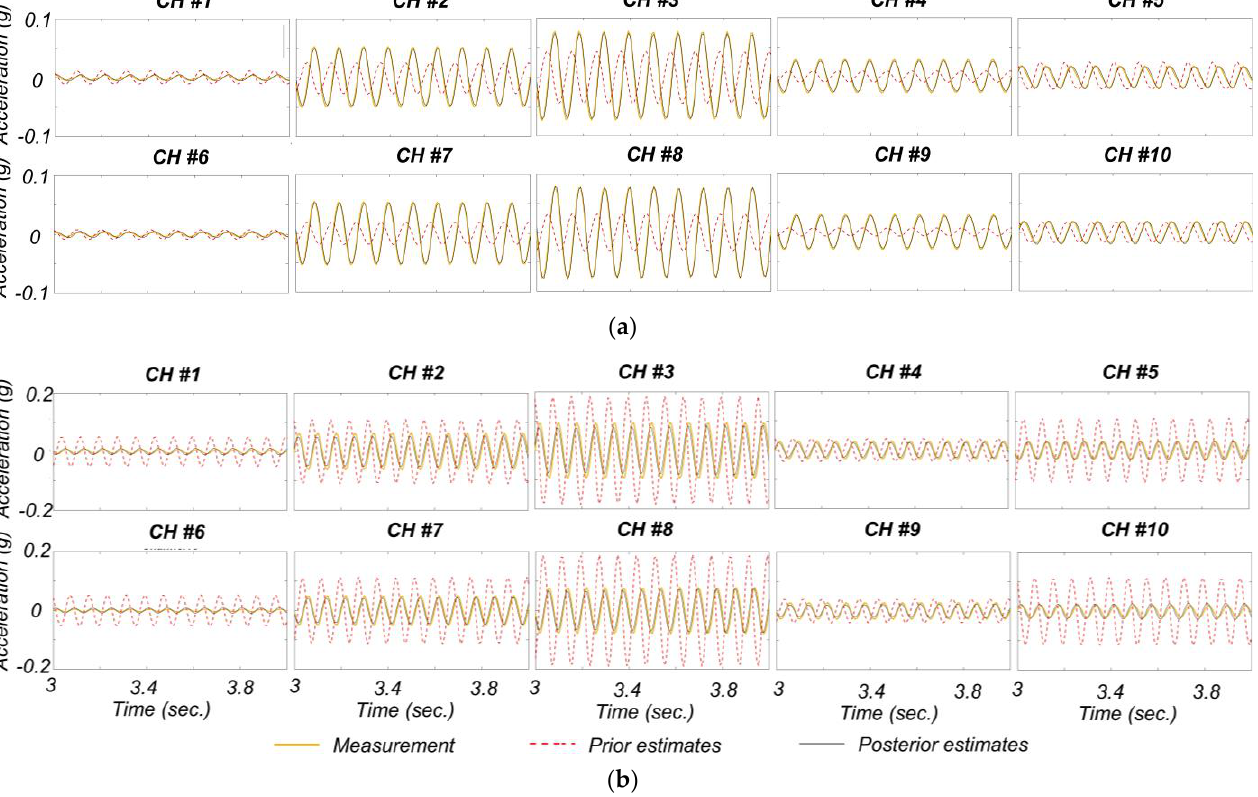
Figure 12. The measured, prior and posterior estimates of FE-predicted responses using Bayesian FE model updating based on Data 1–2: ( a ) excitation frequency of 9.73 Hz and ( b ) excitation frequency of 12.86 Hz. Table 5. RRMSEs (%) between the measurements and FE-predicted responses from the prior and posterior model.